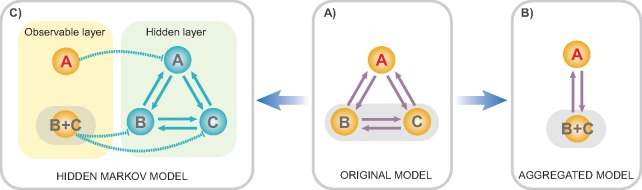
Hidden Markov model and lumpability. This original three-state Markov model (a) can be reduced to a two-state model by either directly aggregating the states (e.g., the states \documentclass[12pt]{minimal}
\usepackage{amsmath}
\usepackage{wasysym}
\usepackage{amsfonts}
\usepackage{amssymb}
\usepackage{amsbsy}
\usepackage{upgreek}
\usepackage{mathrsfs}
\setlength{\oddsidemargin}{-69pt}
\begin{document}
}{}$B$\end{document} and \documentclass[12pt]{minimal}
\usepackage{amsmath}
\usepackage{wasysym}
\usepackage{amsfonts}
\usepackage{amssymb}
\usepackage{amsbsy}
\usepackage{upgreek}
\usepackage{mathrsfs}
\setlength{\oddsidemargin}{-69pt}
\begin{document}
}{}$C$\end{document}) if the model is lumpable (b), or by using HMM with two observable and three hidden states if the model is not lumpable (c).